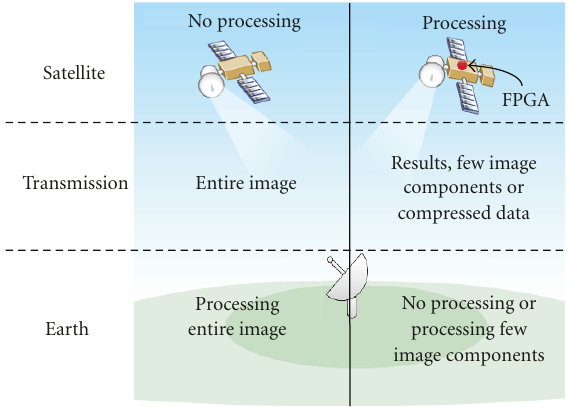
Figure 3: Potential advantages of using reconfigurable hardware in remote sensing data processing.